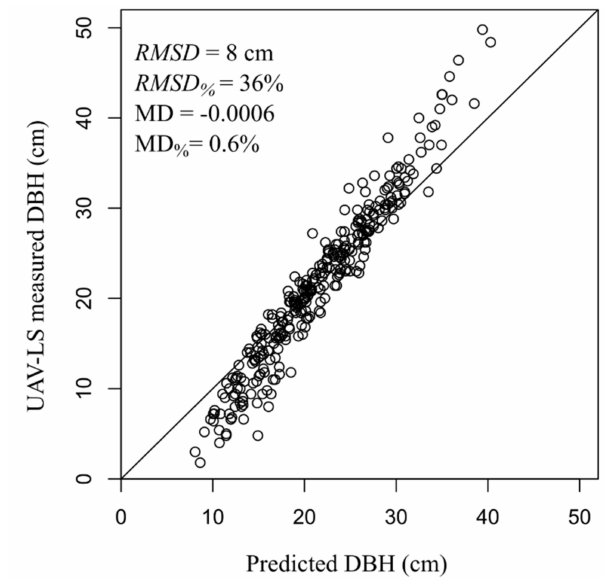
Figure 6. Scatterplot of the UAV-LS measured against predicted DBH (cm). Each point represents a single tree where DBH measurement was feasible using the RANSAC